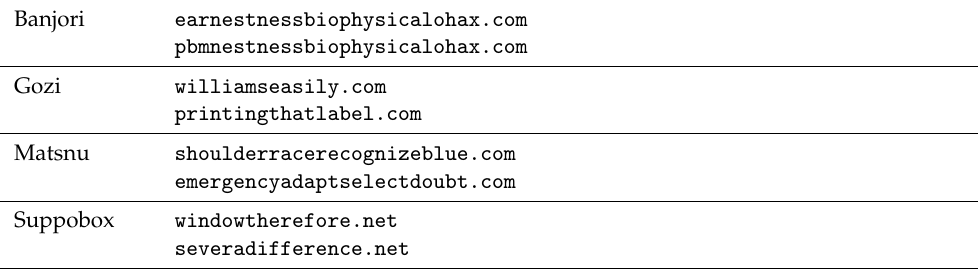
Table 1. Examples of domain names generated by dict-DGA